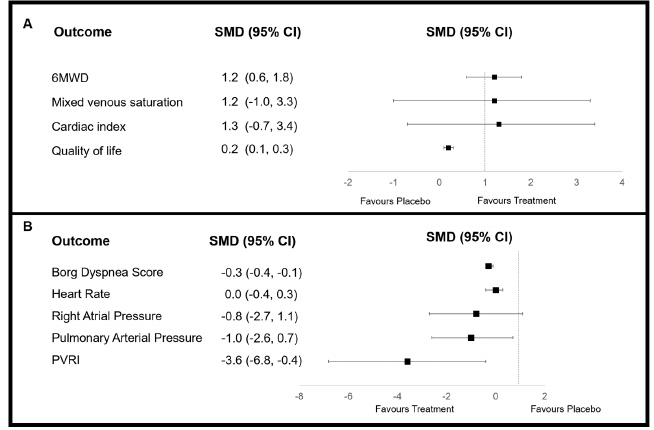
Figure 3. Forest plots of overall change in meta-analysed outcome data for prostacyclin mimetic therapy as determined by standardised mean difference (SMD), where ( A ) an increased value favours treatment and ( B ) a decreased value favours treatment. CI = confidence interval; PVRI = mean change in pulmonary vascular resistance index. Pulmonary arterial pressure refers to mean pressure recorded.